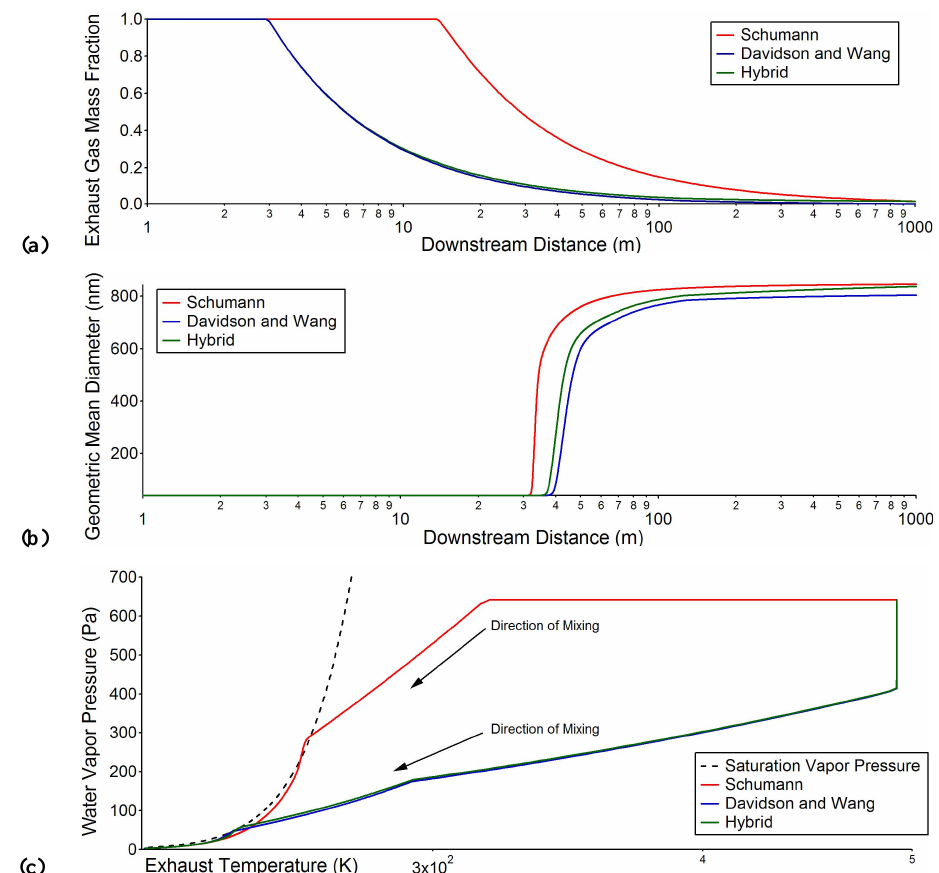
Fig. 3. (a) Exhaust mass fraction determined from the Schumann equation, the Davidson and Wang algorithm, and the hybrid of the two; (b) the predicted values of geometric mean diameter of the ice coated soot particles using different dilution profiles; (c) the water vapor pressure following different mixing trajectories and its relevance to saturation vapor pressure. Because both the Schumann equation and the Davidson and Wang algorithm are set up to match plume properties more than one wingspan downstream, they do not capture the behavior of the potential core region ( < 15m downstream) well. This results in the bended lines in the high temperature ( > 300K), potential core